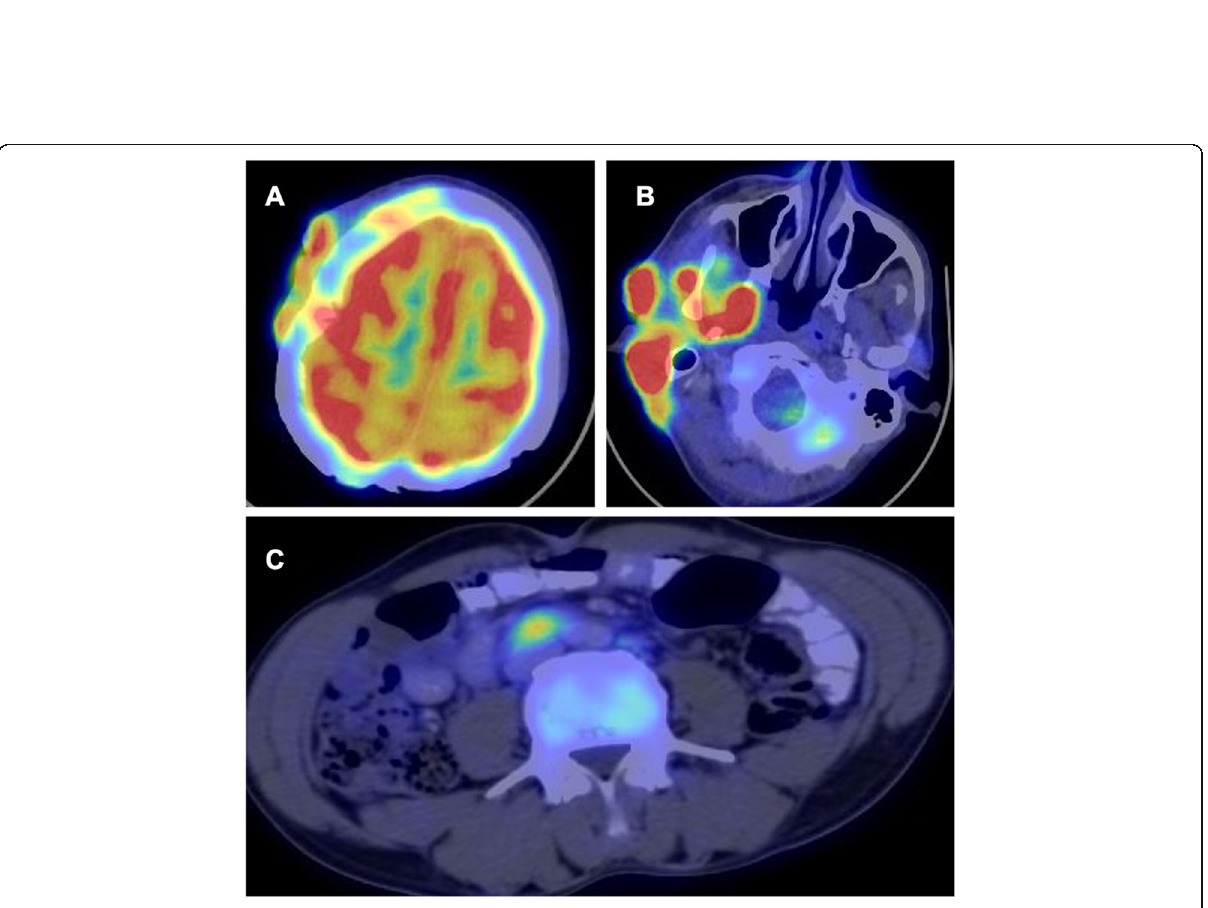
Fig. 5 Positron emission tomography images of the ulcerated lesion. a , b Flanking the right frontal, parietal and temporo-occipital region, extending into the right infratemporal fossa, masseter and lateral pterygoid; c involvement of diaphragmatic lymph